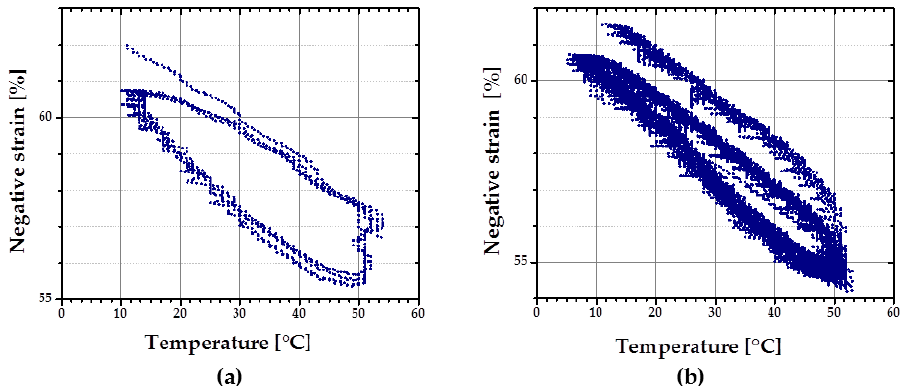
Figure 11. Dependence of compressive strain from the temperature change during cyclic SME tests